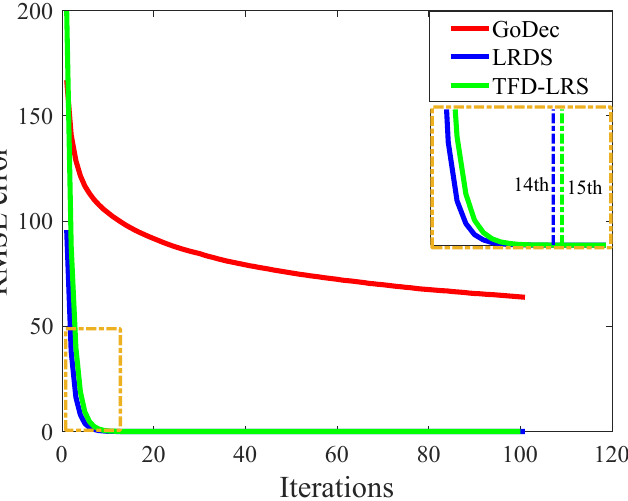
Figure 10. The convergence curves of the root mean square error when utilizing GoDec, LRDS, and TFC-LRS. Table 5. Performance comparison of RFI mitigation algorithms for a simulated snapshot.